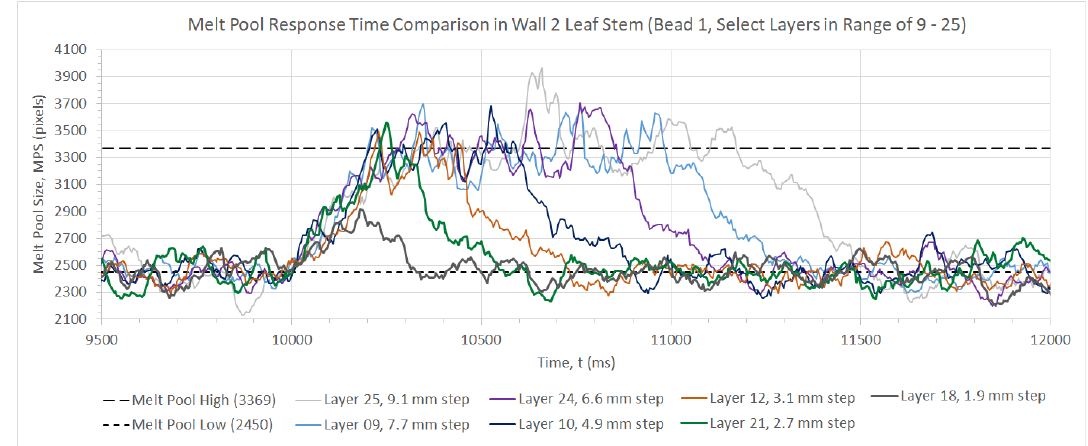
Figure 8. Melt pool response time comparison for Wall 2 leaf stem; bead one, select layers in the range of 9 –